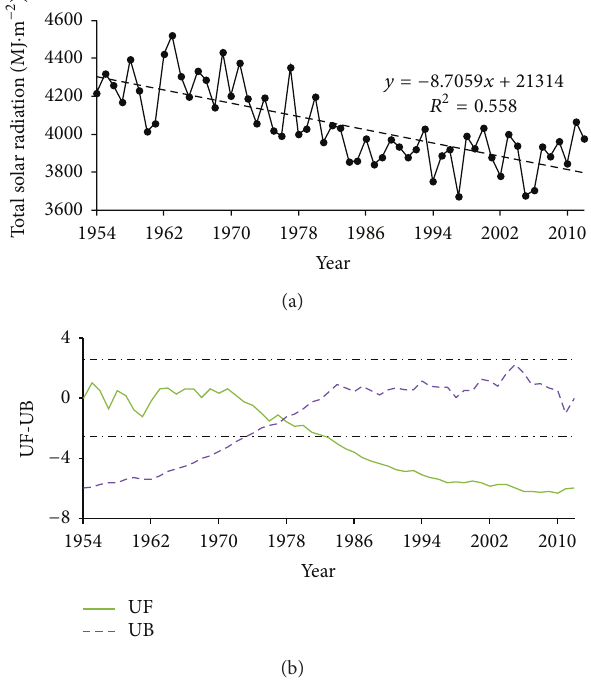
Figure 3: Temporal trend in the yearly total solar radiation (a) and the trend results from the Mann-Kendall method